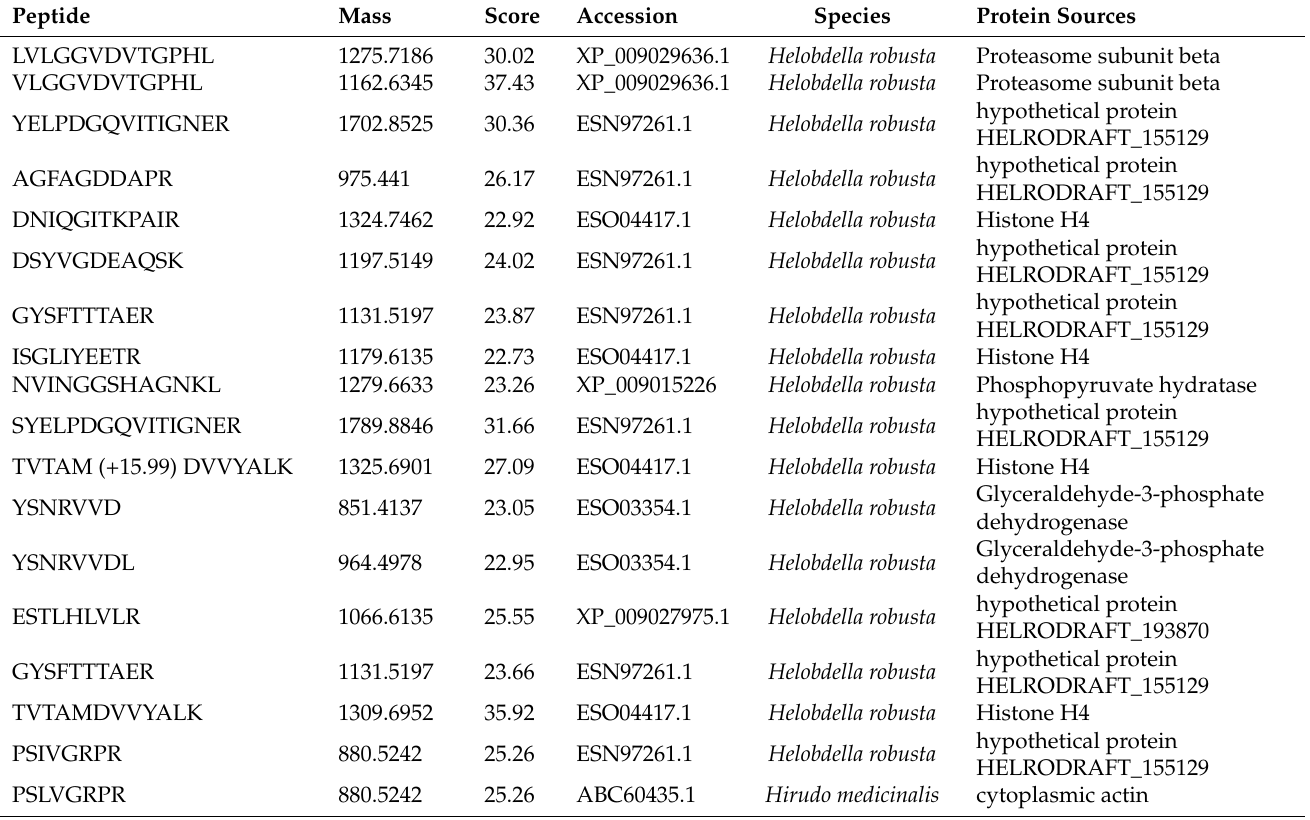
Table 1. Identified peptide